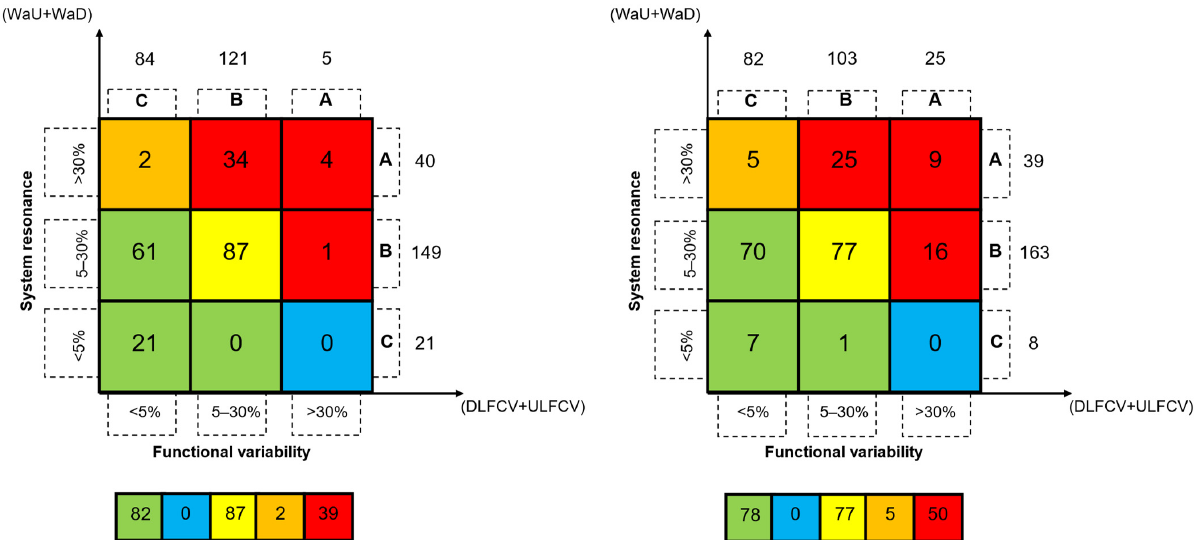
Figure 10. The Functional Variability-System Resonance Matrix (FVSRM), left for the human driver and right for the automation.